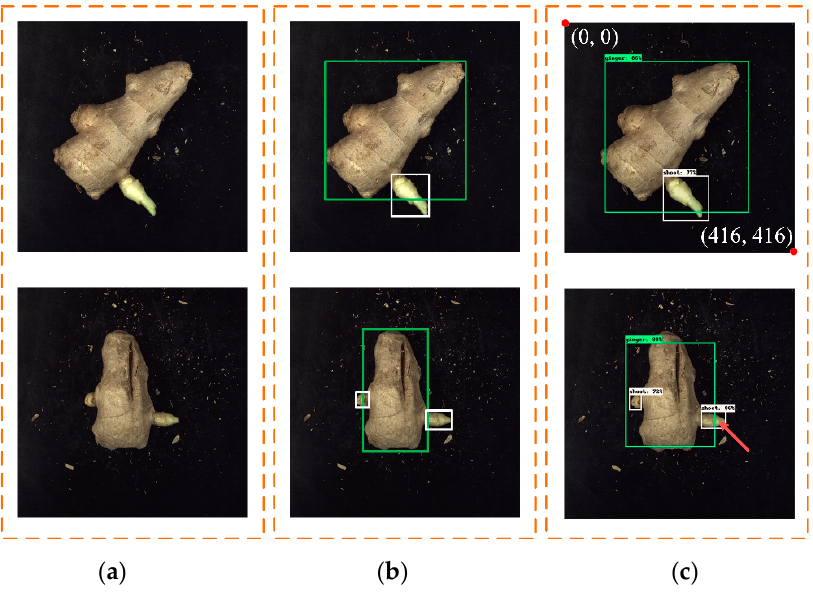
Figure 9. Ginger seed image recognition results. ( a ) Origin images, ( b ) labeled images, and ( c ) identified results.